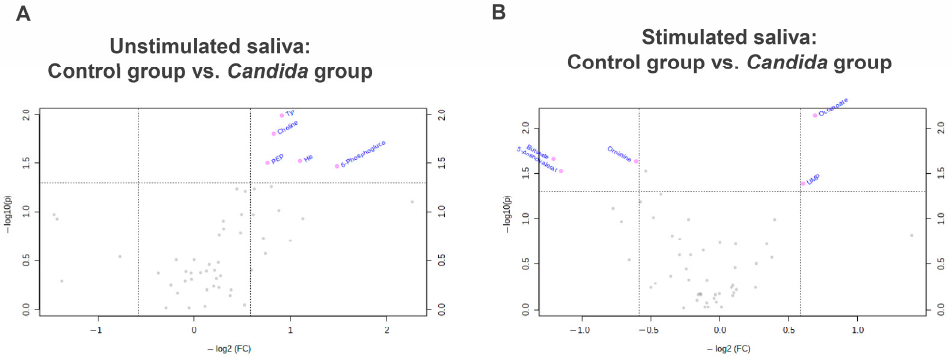
Figure 3. Volcano analysis of metabolites. ( A ) unstimulated saliva. ( B ) stimulated saliva. X-axes indicate the log 2 of fole change ( Candida group/control group) of the averaged concentration. The metabolites above the horizontal lines (Y = 1.3, i.e., p = 0.05) indicate the significantly different between two groups. Mann–Whitney test was used to calculate the p -values.